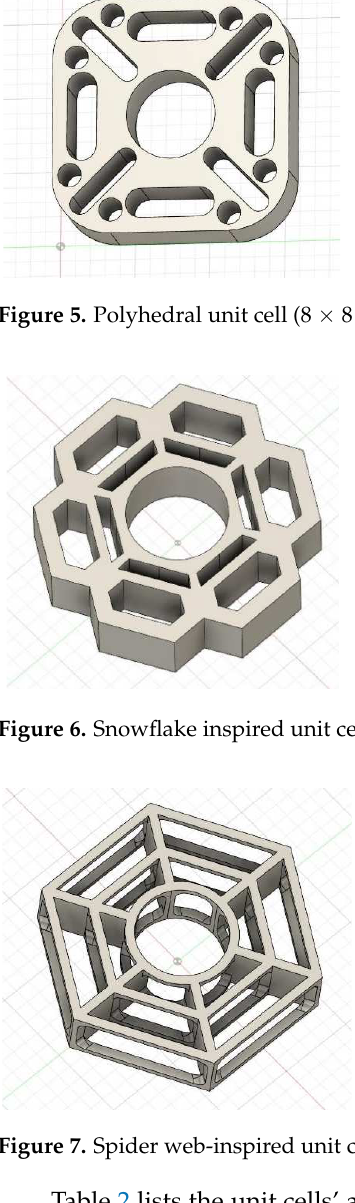
Figure 4. Acoustic foam inspired unit cell (8 × 8 × 4 mm 3 ).